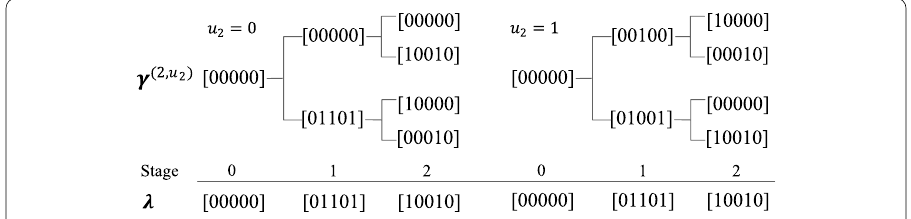
Fig. 2 The common column binary tree of x ( 2,0 ) and x ( 2,1 ) : the left part is for x ( 2,0 ) and the right part is for x ( 2,1